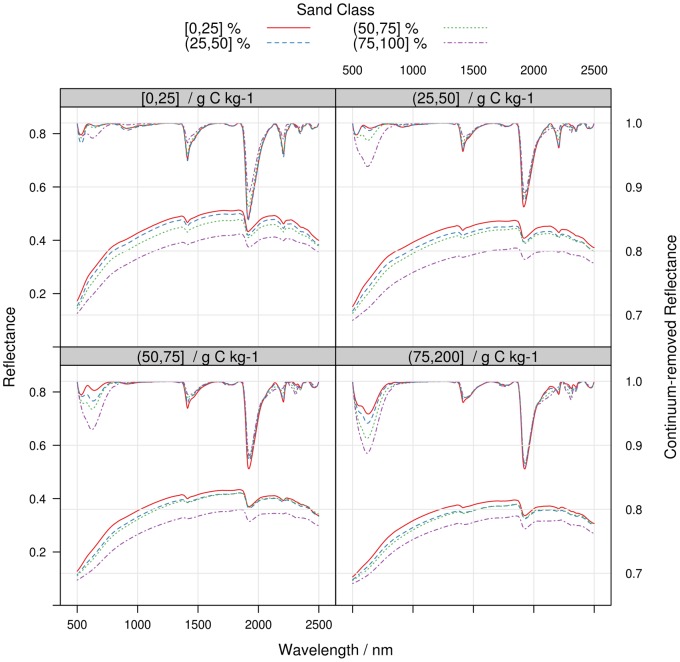
Mean reflectance (left scale) and continuum-removed reflectance (right scale) spectra of LUCAS mineral soil samples, computed for arbitrary sand and SOC classes.The sand classes are 0–25%, 25–50%, 50–75%, 75–100% and the SOC classes are 0–25 g C kg−1, 25–50 g C kg−1, 50–75 g C kg−1, 75–200 g C kg−1. Each panel regroups samples of a given SOC interval.